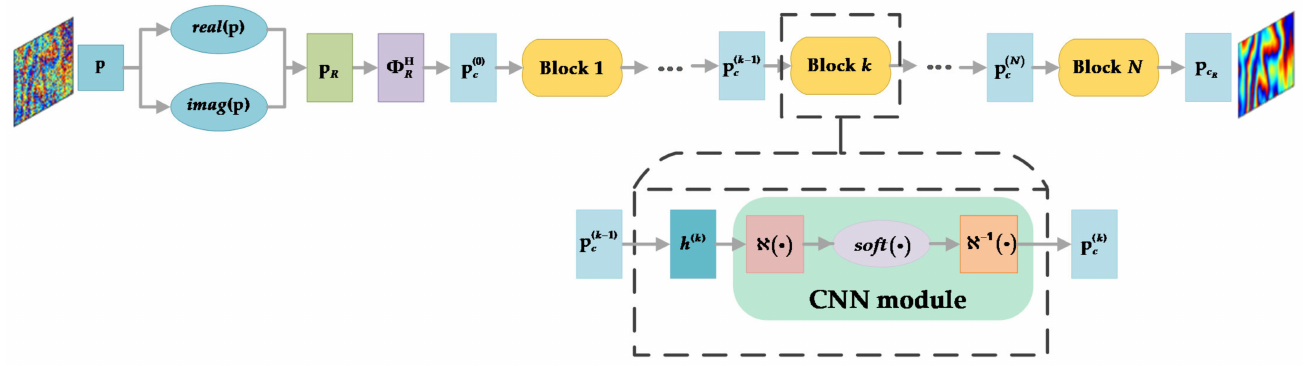
Figure 2. The architecture of the SMD-Net.